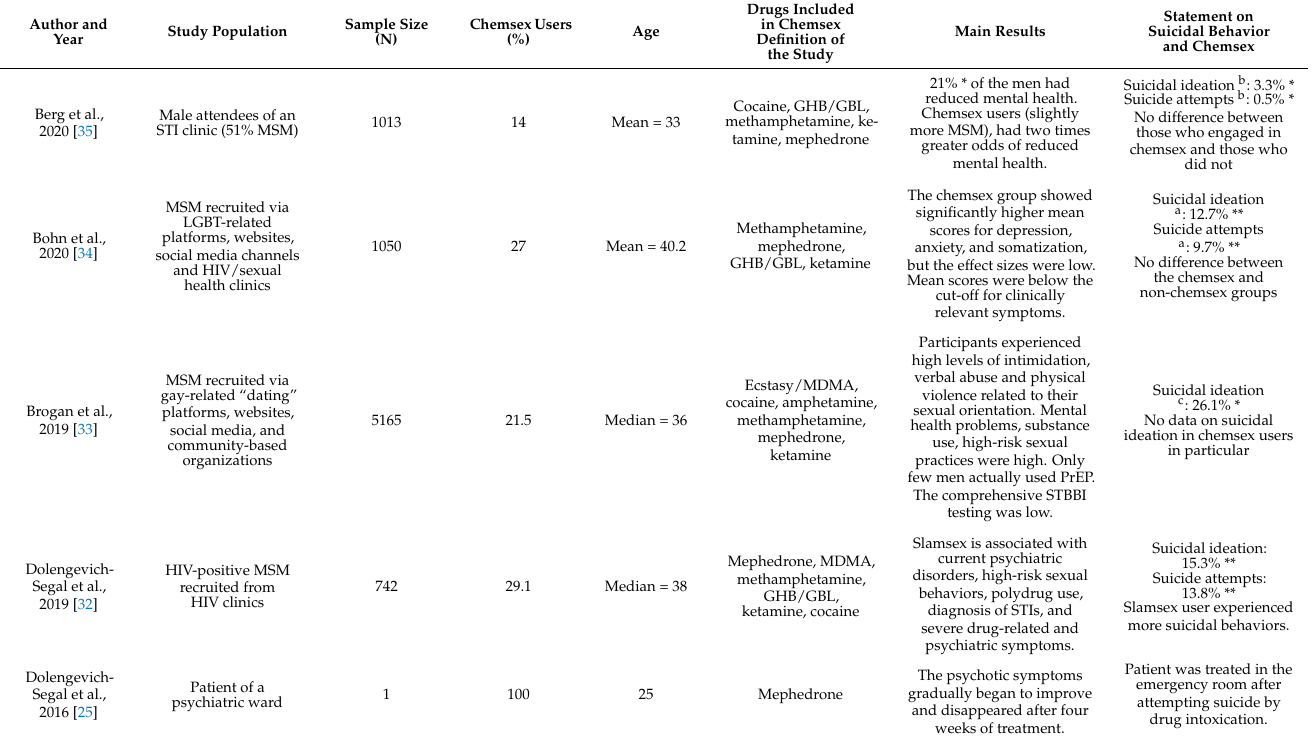
Table 2. Summary of